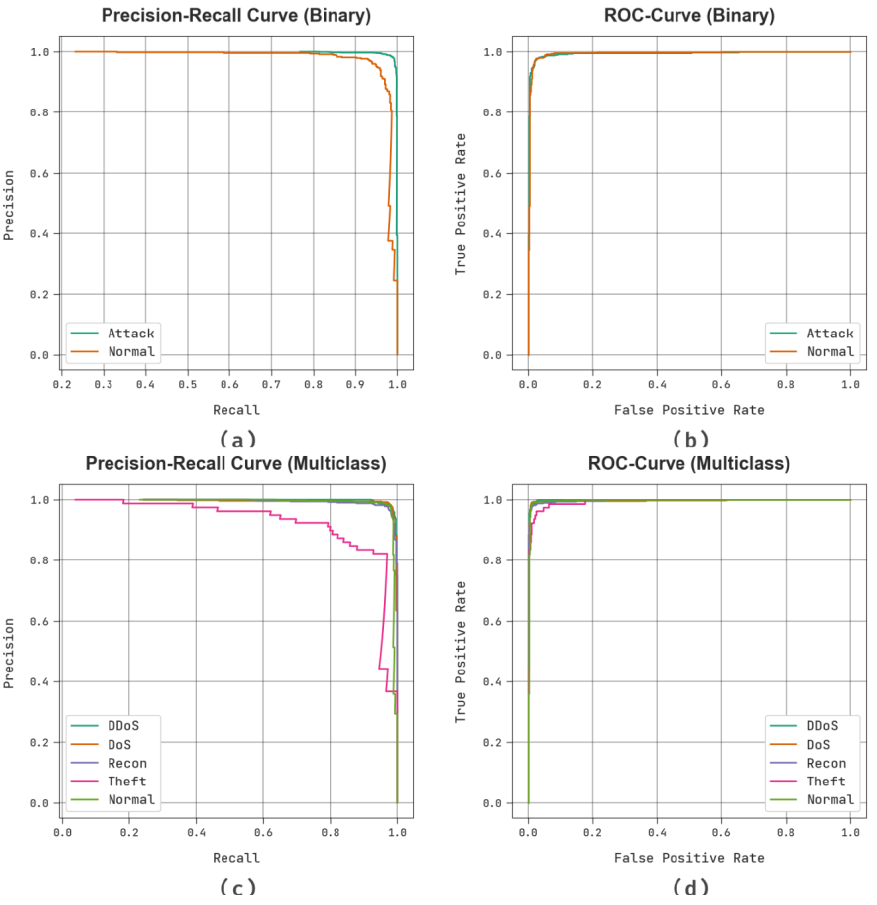
Figure 11. Binary dataset of ( a ) the PR curve and ( b ) ROC curve. Multiclass dataset ( c ) PR curve and ( d ) ROC curve.